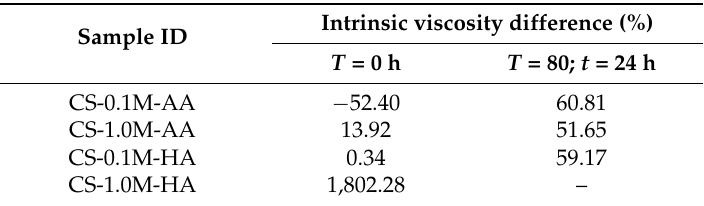
Table 4. Percentage of variation of measured viscosity with respect to its values calculated by means of MHS, maximum and minimum absolute variations are highlighted.